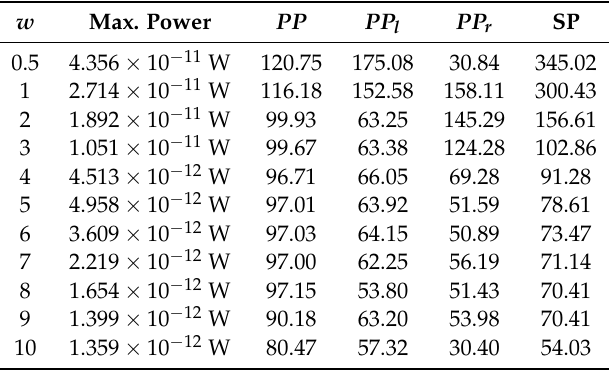
Table 1. Optimized thresholds and their corresponding